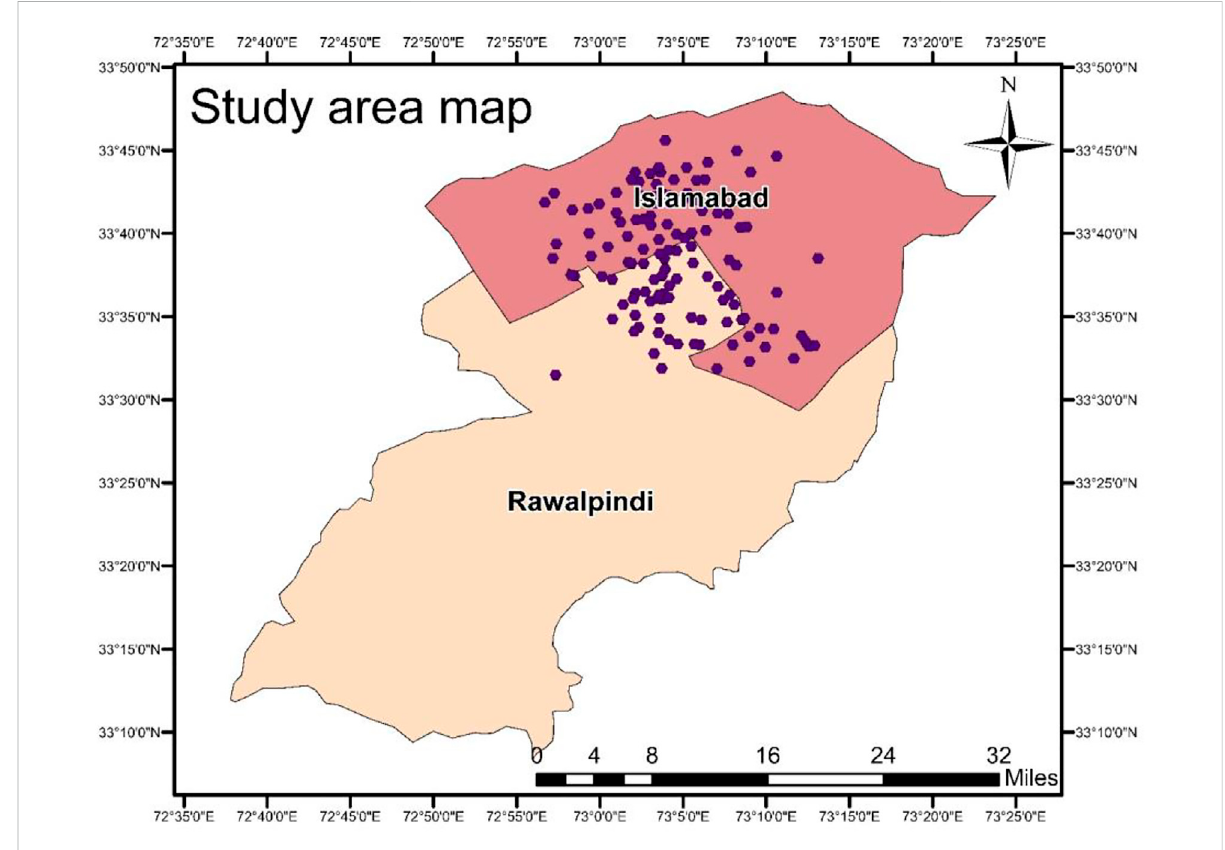
FIGURE 1 Location map of Rawalpindi-Islamabad (the “ twin cities ” ) showing sampling